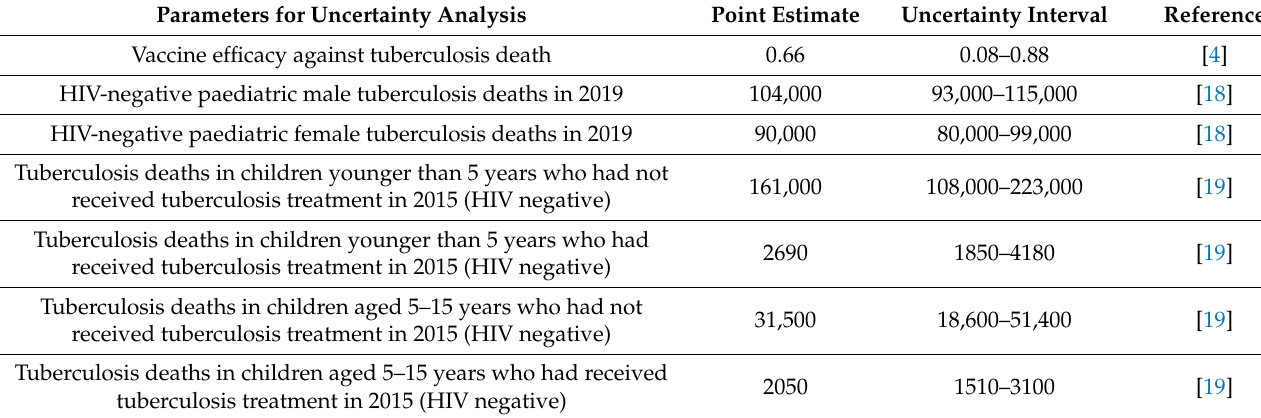
Table 2. Data inputs used for developing uncertainty